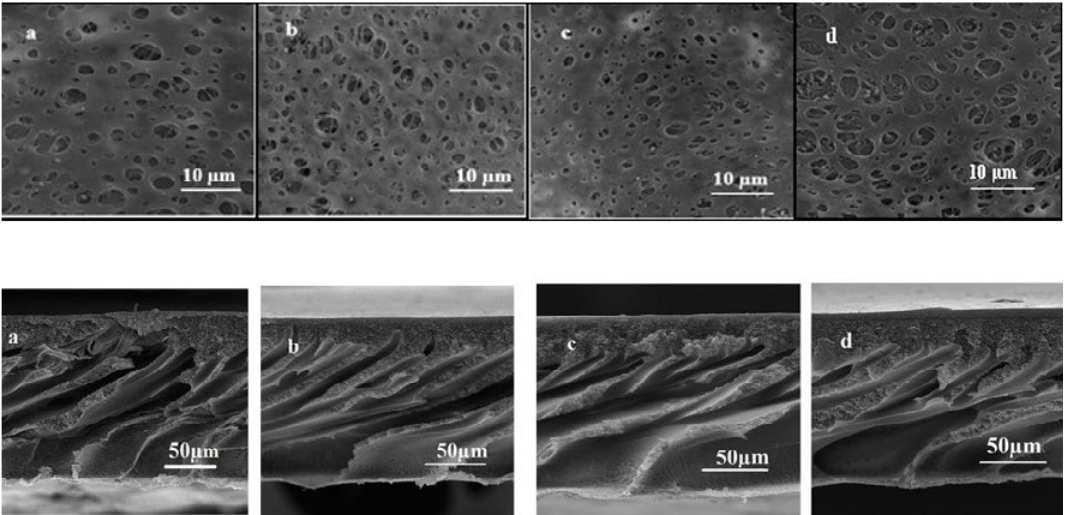
Fig. 2. SEM images of top surface (top) and cross-sectional (bottom) of: (a) PSf, (b) PSf/SND (0.5 wt%) (c) PSf/SND (1.0 wt%), (d) PSf/SND (1.5 wt%)